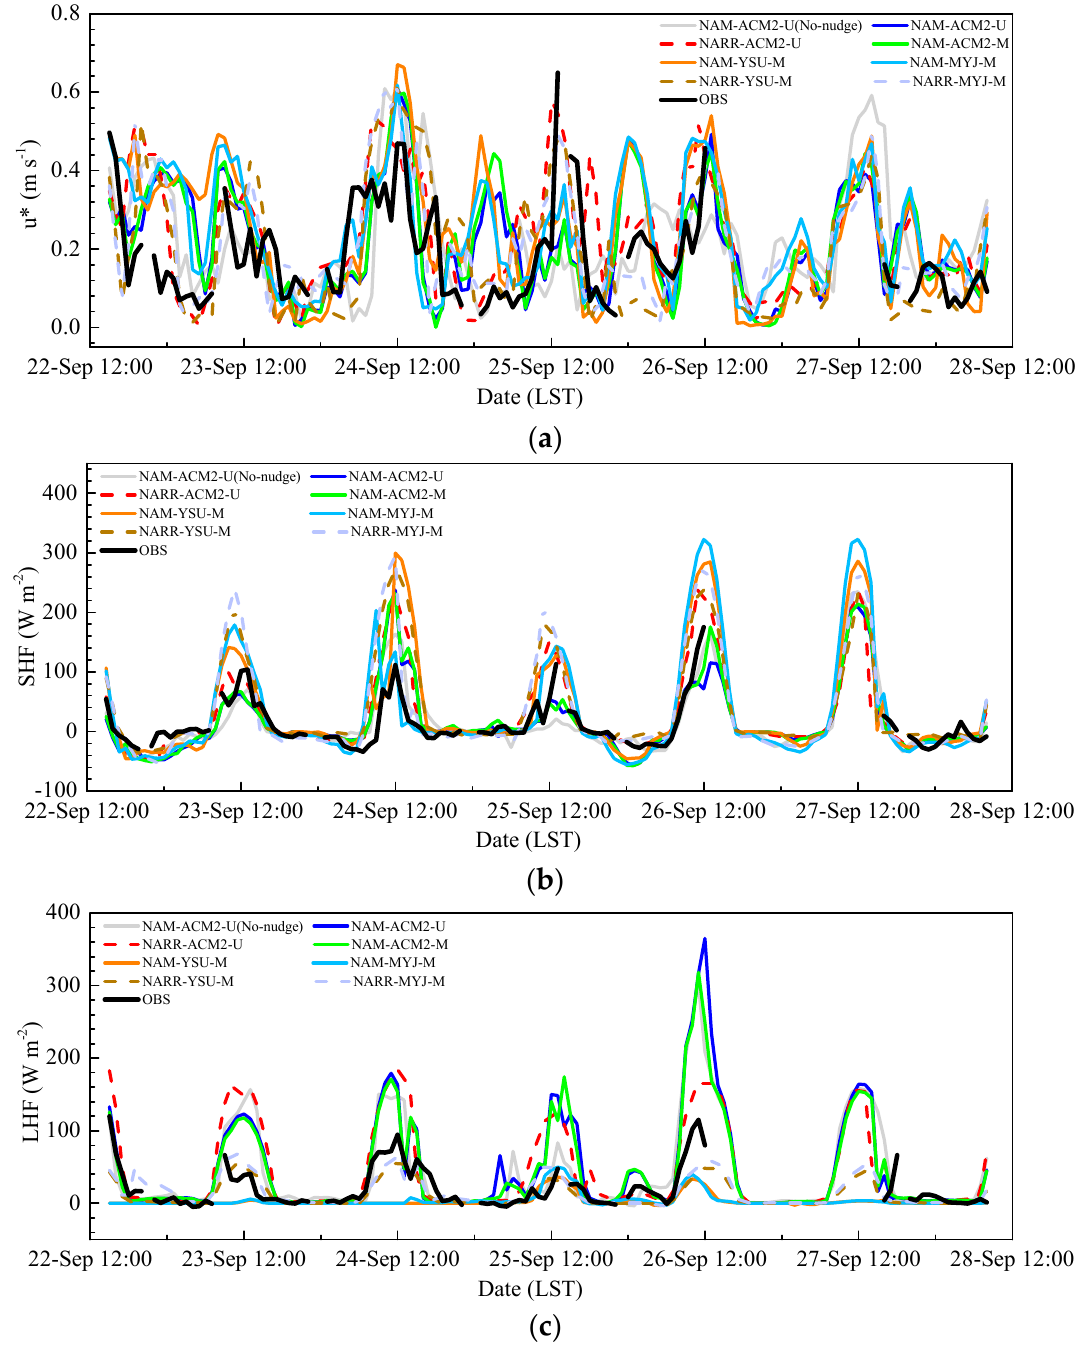
Figure 3. Hourly time evolution of ( a ) friction velocity, ( b ) sensible heat flux, and ( c ) latent heat flux simulated at the flux tower site in the innermost domain (0.5 km resolution) with observational data for 22 to 28 September.